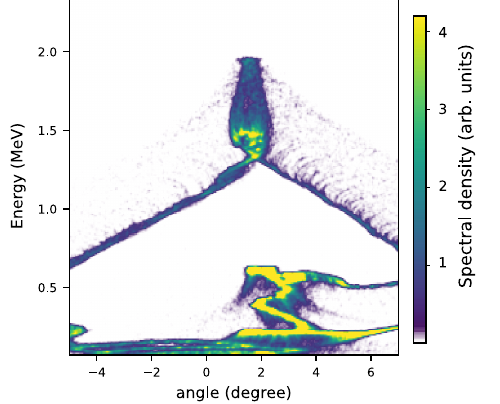
Lewis,FIG. 4. Final angular-spectral distribution of protons for a laser energy of 30 mJ and 70 fs pulse